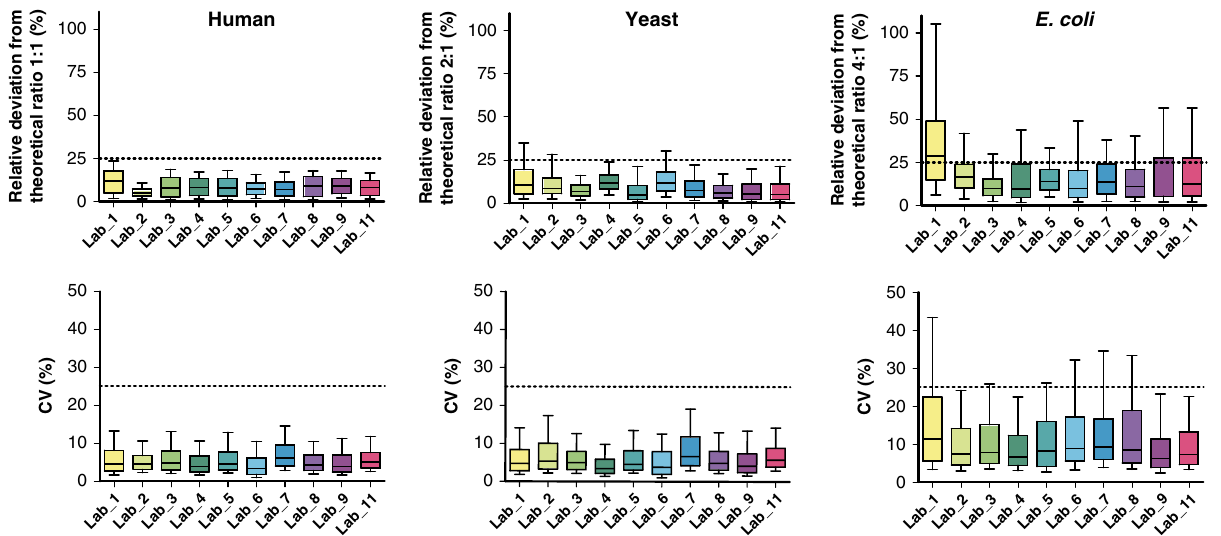
Fig. 5 Quantitative performance metrics from analyses of the mixed proteome samples. The evaluation was based on the experimentally determined abundance changes of the systematically quanti fi ed proteins (every day by every laboratory) between controlled samples A and B ( n = 4565) using three technical replicates. In the upper panels, the distribution of deviation from theoretical protein abundance changes for the three organisms (in %) was plotted for each laboratory through boxplots with center line, box bounds, and whiskers representing the median, 1st/3rd quartile, and 10th/90th percentile, respectively. Horizontal dashed lines were added at 25% relative deviation, as a reference value. In the lower panels, the distribution of the coef fi cients of variation obtained on the determined protein abundance changes for the three organisms across the various evaluation days (CV in %) was plotted for each laboratory through boxplots with center line, box bounds, and whiskers representing the median, 1st/3rd quartile, and 10th/90th percentile, respectively. Horizontal dashed lines were added at 25% CV, as a reference value. Source data are provided as a Source Data fi